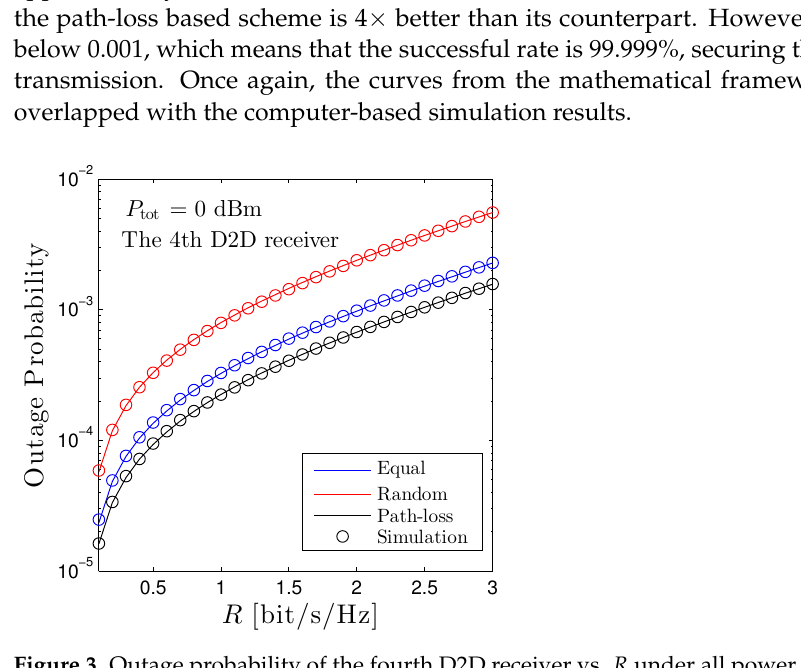
Figure 3. Outage probability of the fourth D2D receiver vs. R under all power allocation methods. Solid lines are plotted by employing (12) and markers are Monte Carlo simulation.